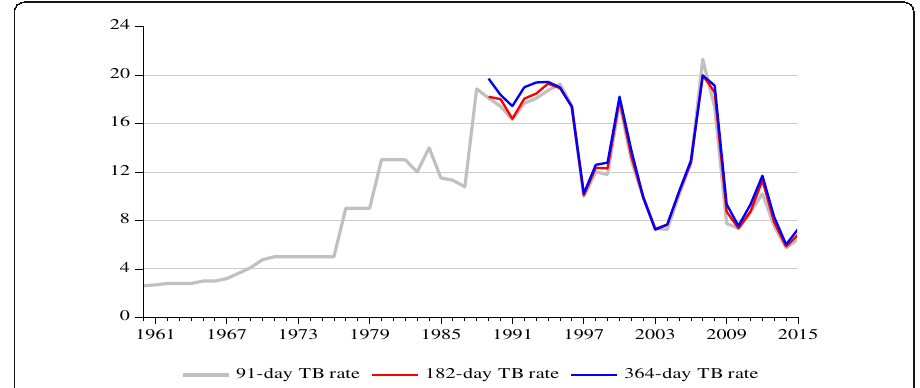
Fig. 1 Time plot of annual interest rates in Sri Lanka. Source: author ’ s representation of CBSL